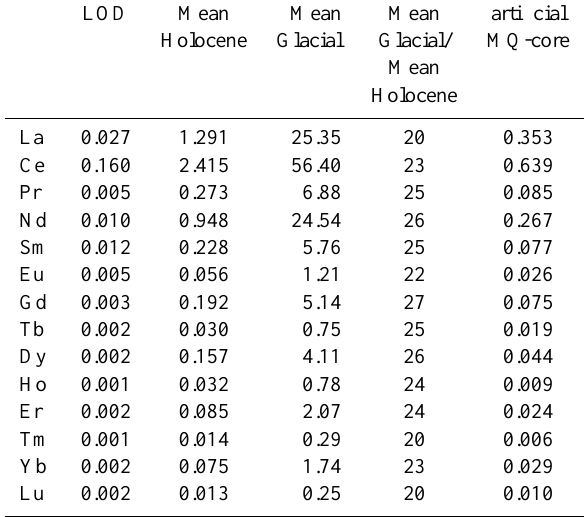
Table 1. Instrumental detection limit (LOD), mean Holocene (13300–7500yrBP) and glacial (26500–16000yrBP) REE con- centrations in the EDML ice core and REE concentration in an arti- ficial MQ ice core. Values are given in pg · g − 1